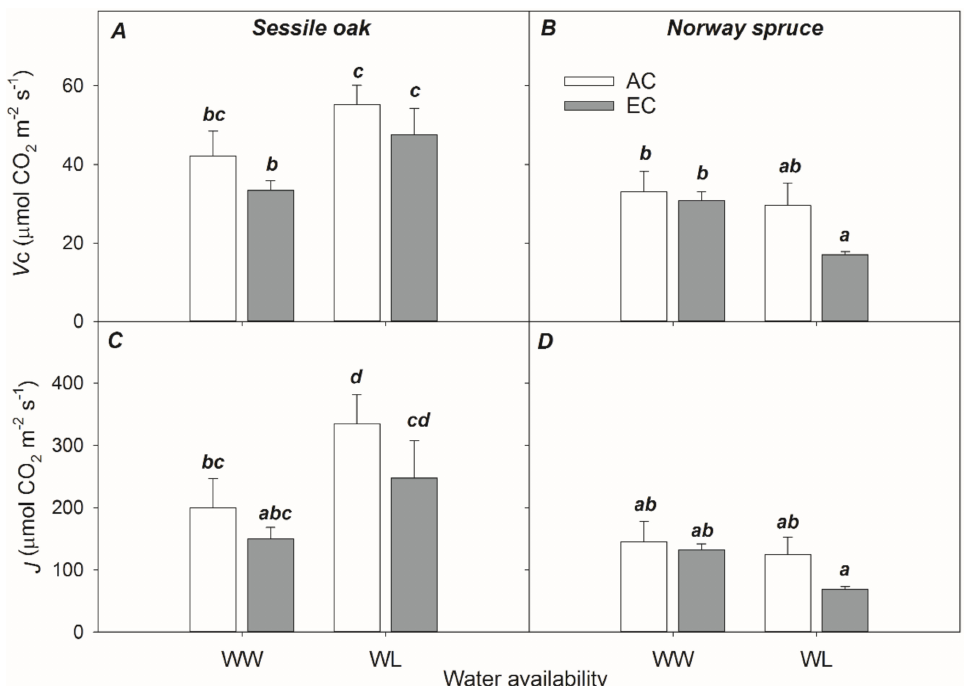
Figure 5. Effect of CO 2 concentration and water availability on in vivo rates of Rubisco carboxylation ( V C ; ( A , B )) and electron transport ( J ; ( C , D )) in sessile oak (left) and Norway spruce (right) saplings. Both parameters were derived from A – C i response curves estimated at saturating light intensity and temperature of 25 ◦ C. The measurements were made during the second growing season of cultivation under manipulated conditions: AC—ambient CO 2 concentration (~400 µ mol CO 2 mol –1